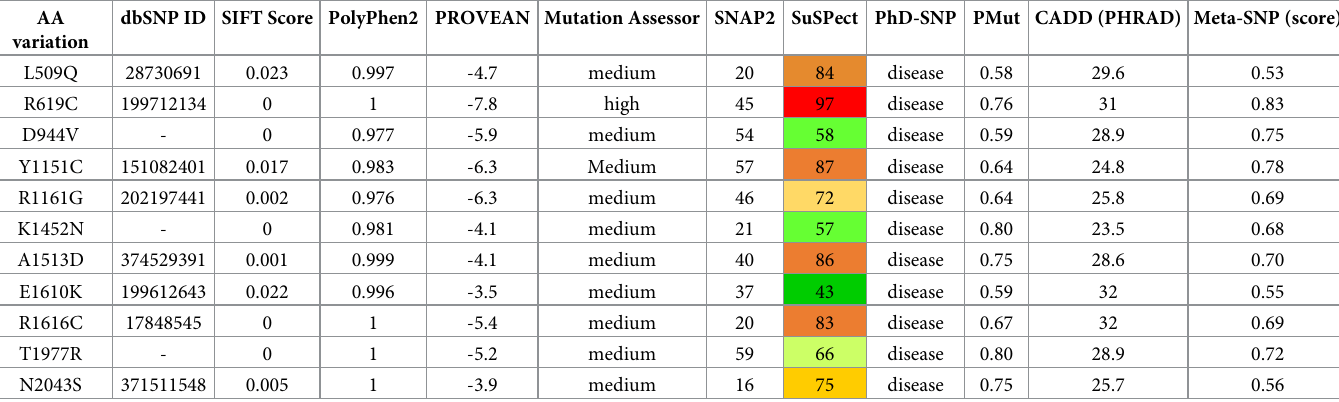
Table 2. The predictions and scores of the most deleterious nsSNPs determined by 10 bioinformatics tools along with their dbSNP IDs if available. AA